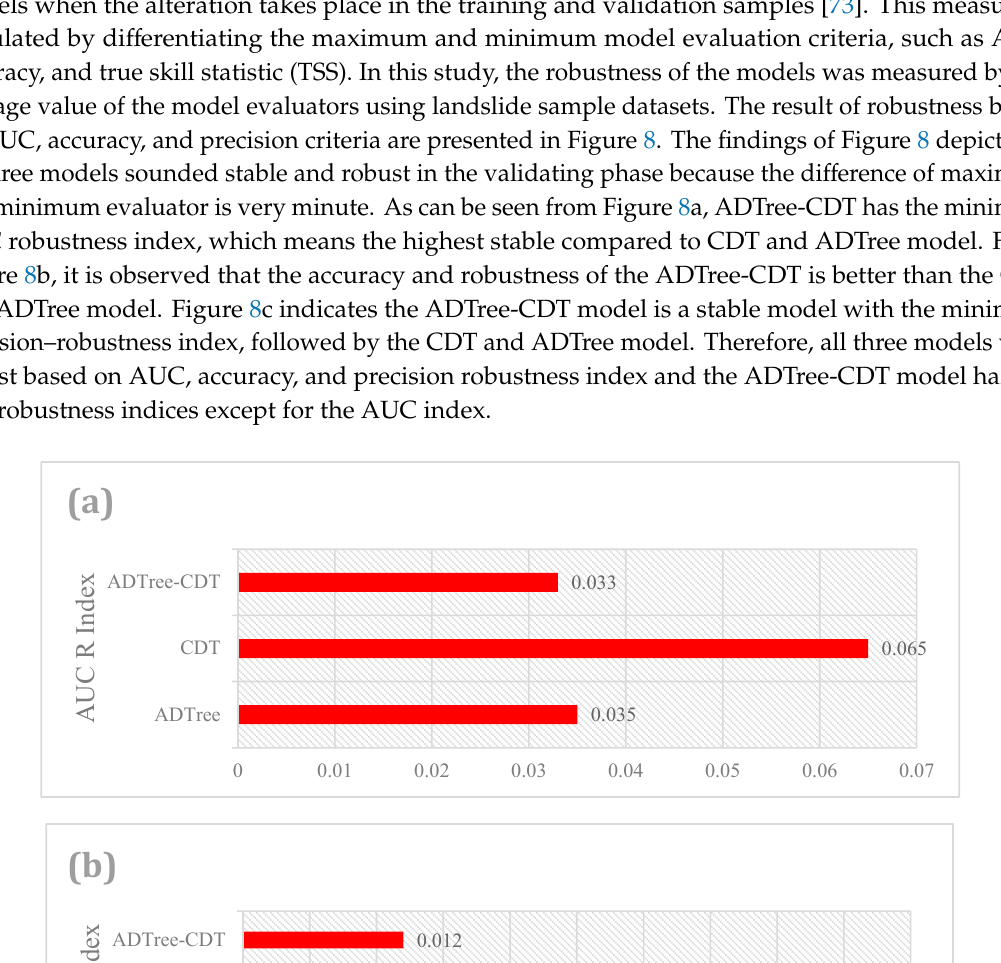
Table 2. The accuracy assessment and validation result of three Machine Learning (ML) models by using area under the curve (AUC), accuracy, and precision